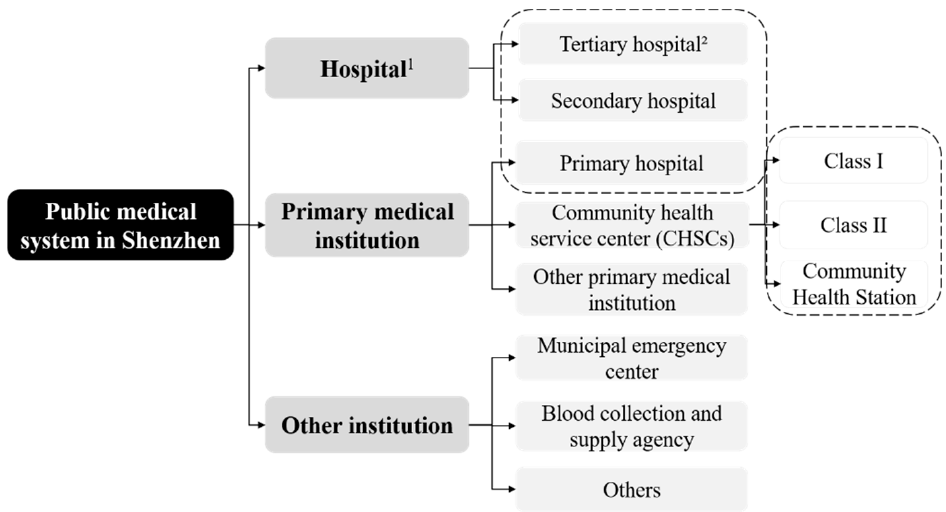
Figure 1. Shenzhen public healthcare service system. 1 Hospitals are divided into public hospitals and social hospitals. This paper only discusses public hospitals. 2 Tertiary hospitals can provide the highest quality of care and have advantages in function, facilities, and technical strength, followed by secondary hospitals.